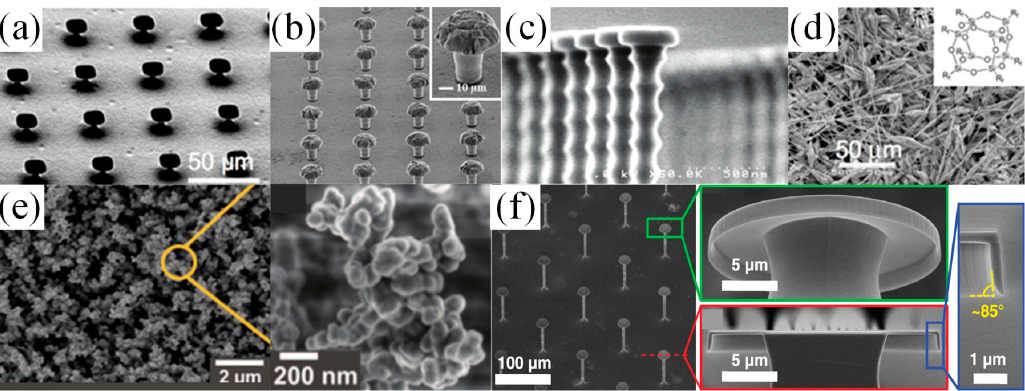
Figure 6. Examples of superomniphobic surface designs. ( a ) Micro hoodoo structures with a rectangular SiO 2 cap on Si micro-pillars. Reproduced with permission from [71], published by PNAS, 2008. ( b ) Mushroom structure of copper surfaces. Reproduced with permission from [72], published by Nature, 2015. ( c ) Nano-nail structures. Reproduced with permission from [73], published by ACS Publications, 2008. ( d ) Fluorinated electrospun fibers [71]. ( e ) Candle soot structure after being coated with silica nanoshell and after carbon core removal by high-temperature sintering. Reproduced with permission from [79], published by Science, 2012. ( f ) Microposts with doubly re-entrant overhangs. Reproduced with permission from [67], published by Science, 2014.